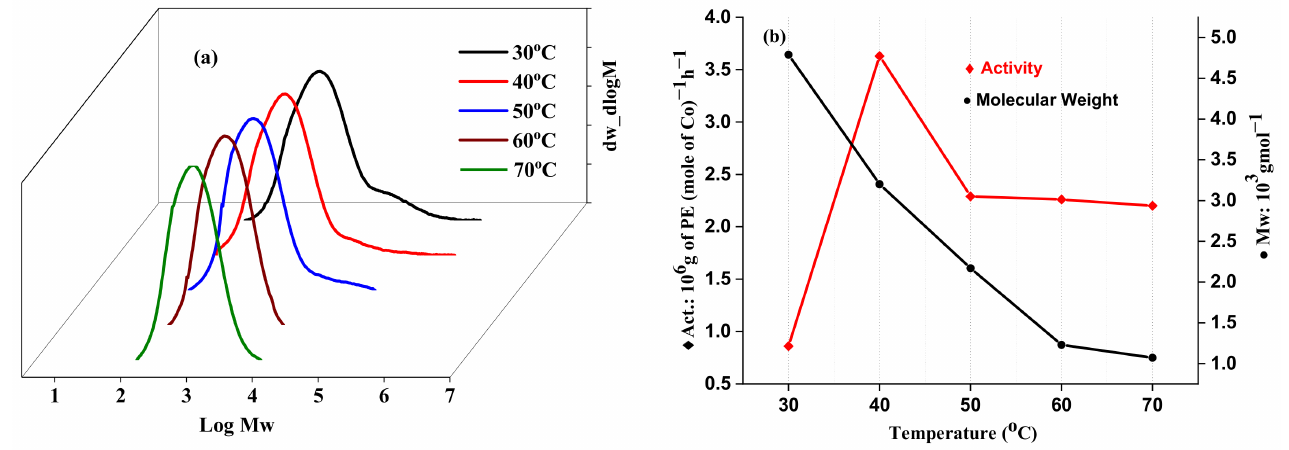
Figure 6. GPC curves of the obtained polyethylene ( a ); activity and M w as a function of reaction temperature ( b ) for the Co1 /MMAO system (Table 3, entries